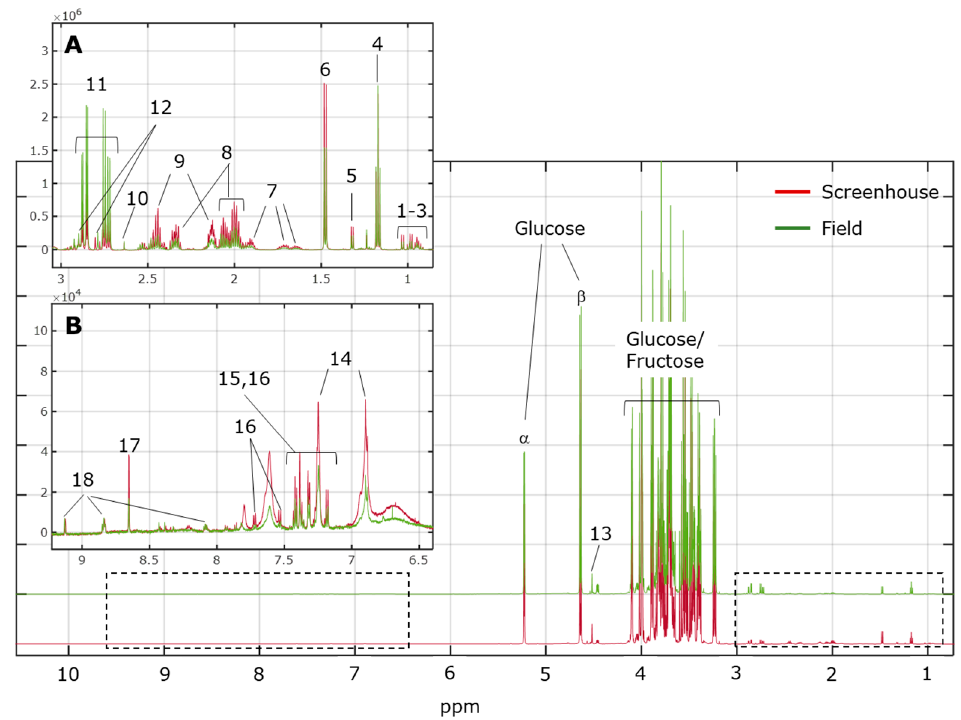
Figure 2. Representative 1 H NMR spectra of must samples from the screenhouse and field experi- ments. ( A ) Expansion of the aliphatic region (dotted rectangle, 0.5 − 3.0 ppm). ( B ) Expansion of the aromatic region (dotted rectangle, 6.5 − 9.5 ppm). Keys: 1. isoleucine; 2. leucine; 3. valine; 4. ethanol; 5. lactate; 6. alanine; 7. arginine; 8. proline; 9. glutamine; 10. succinate; 11. malate; 12. citrate; 13. tartrate; 14. tyrosine; 15. phenylalanine; 16. tryptophan; 17. formate; 18. trigonelline.